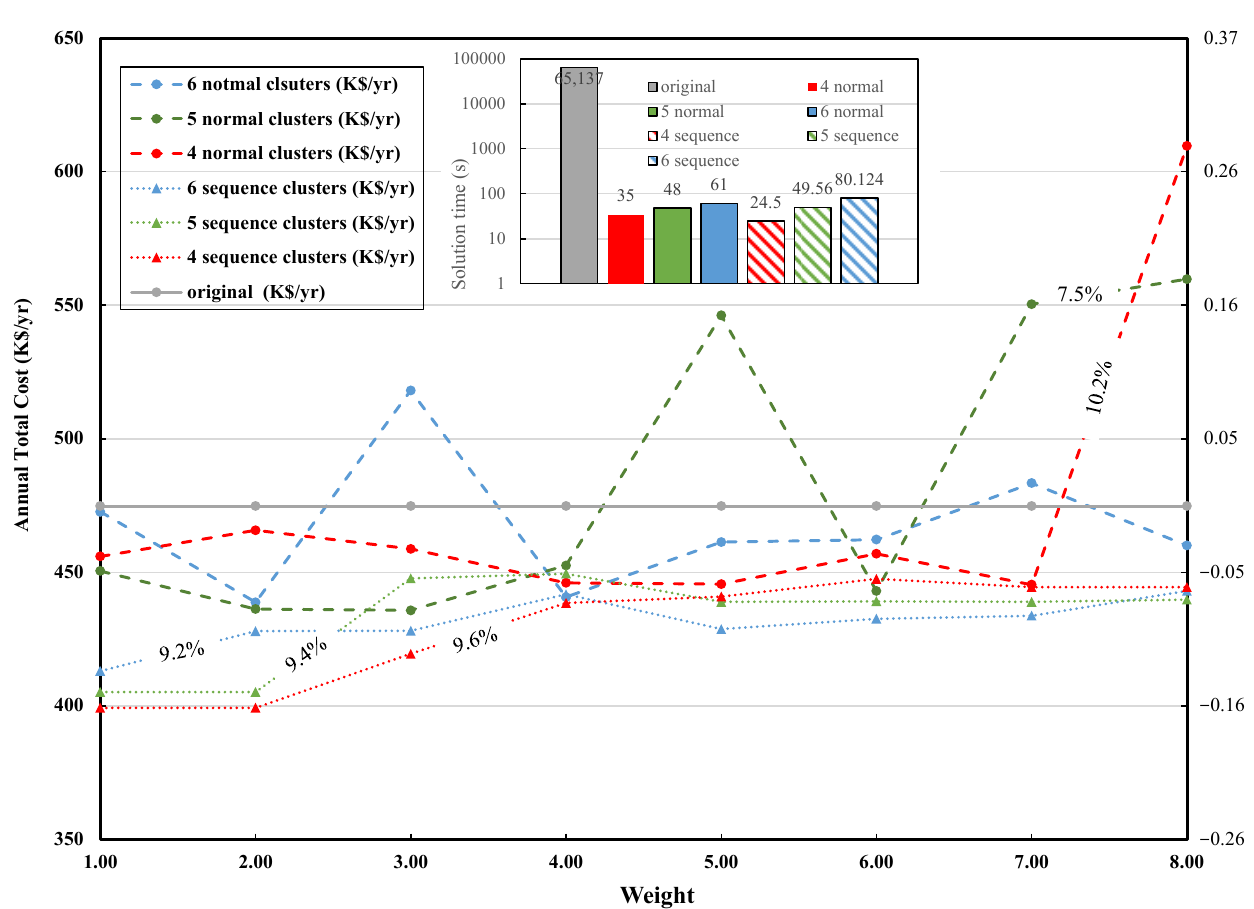
Figure 10. Comparison between the original and clustered energy hub solutions in terms of solution quality and time under the GHG emissions constraint.